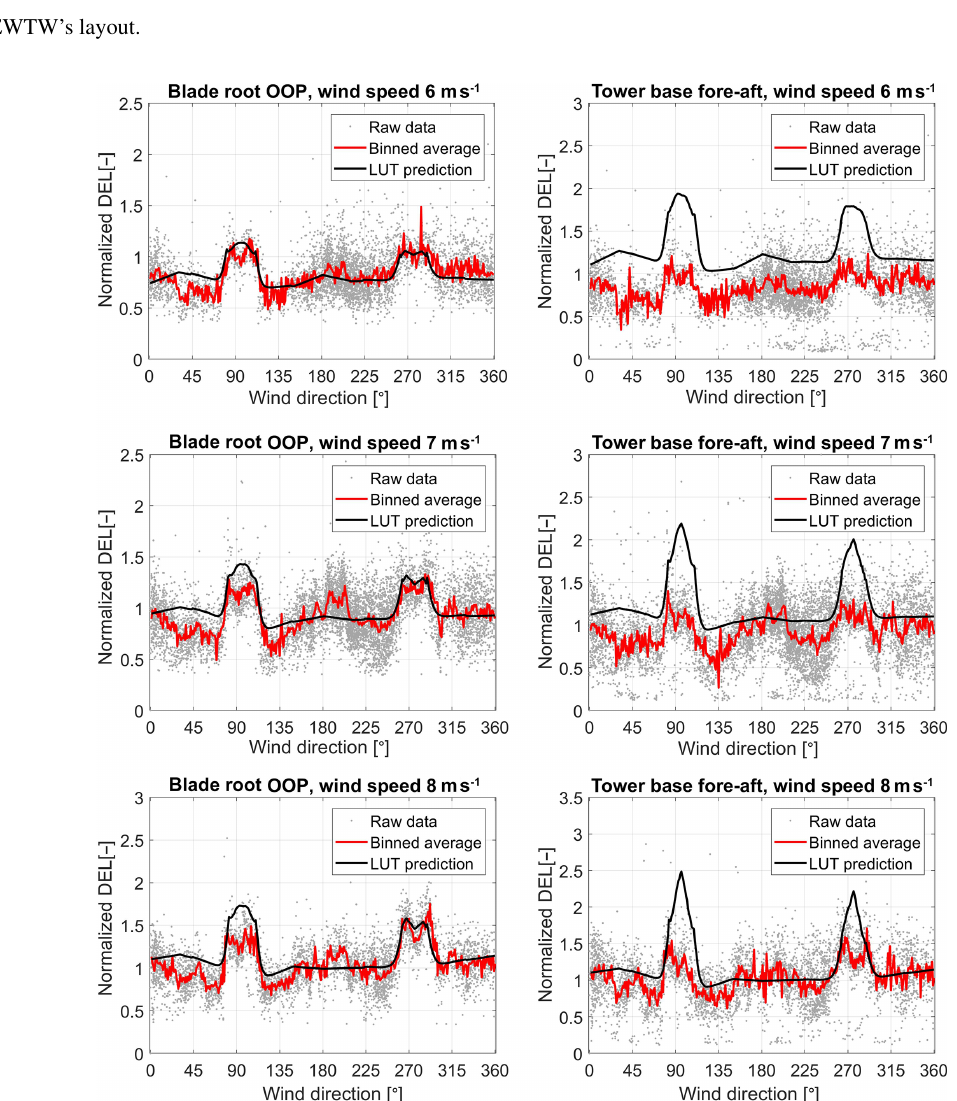
Figure 8. Comparison of LUT load prediction to EWTW measurements for 6, 7, and 8ms − 1 .